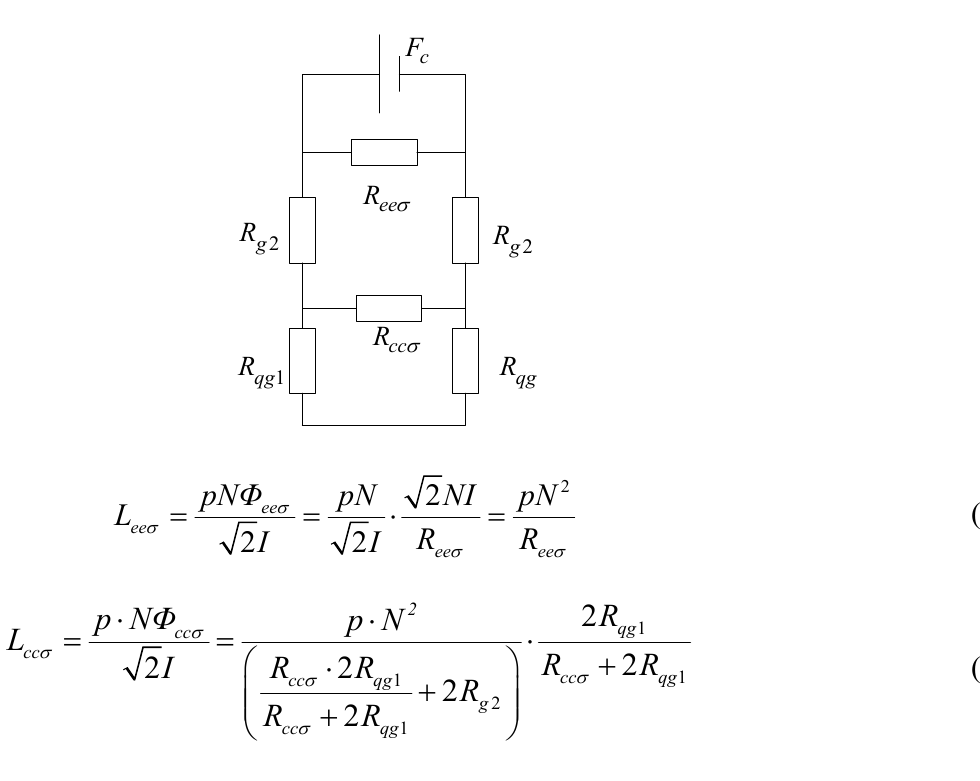
Figure 7. Simplified magnetic